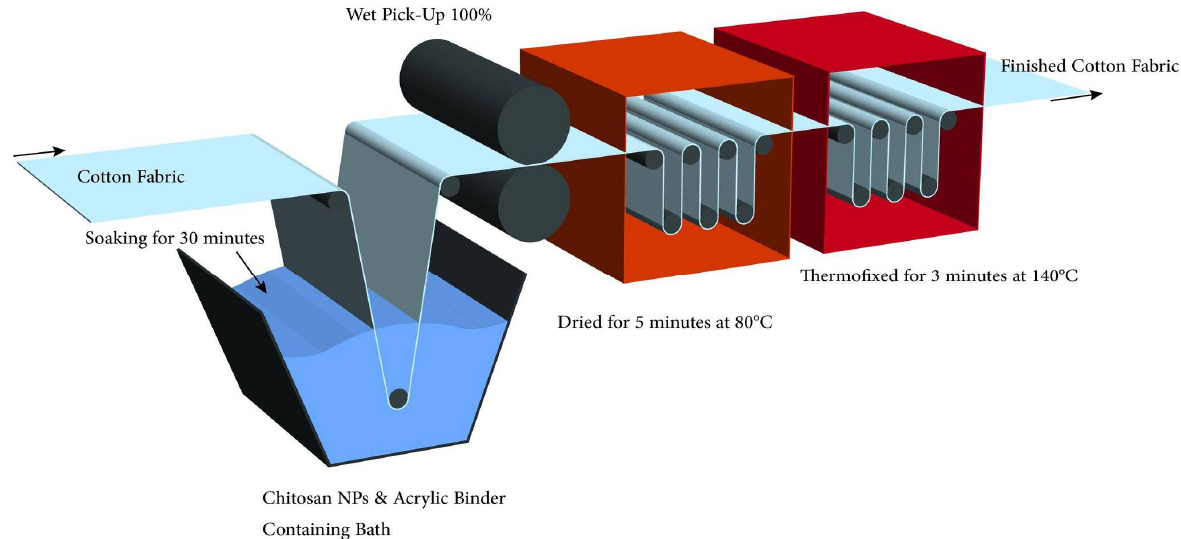
Figure 1. Finishing of cellulosic fabrics with chitosan nanoparticles via pad-dry-cure process.